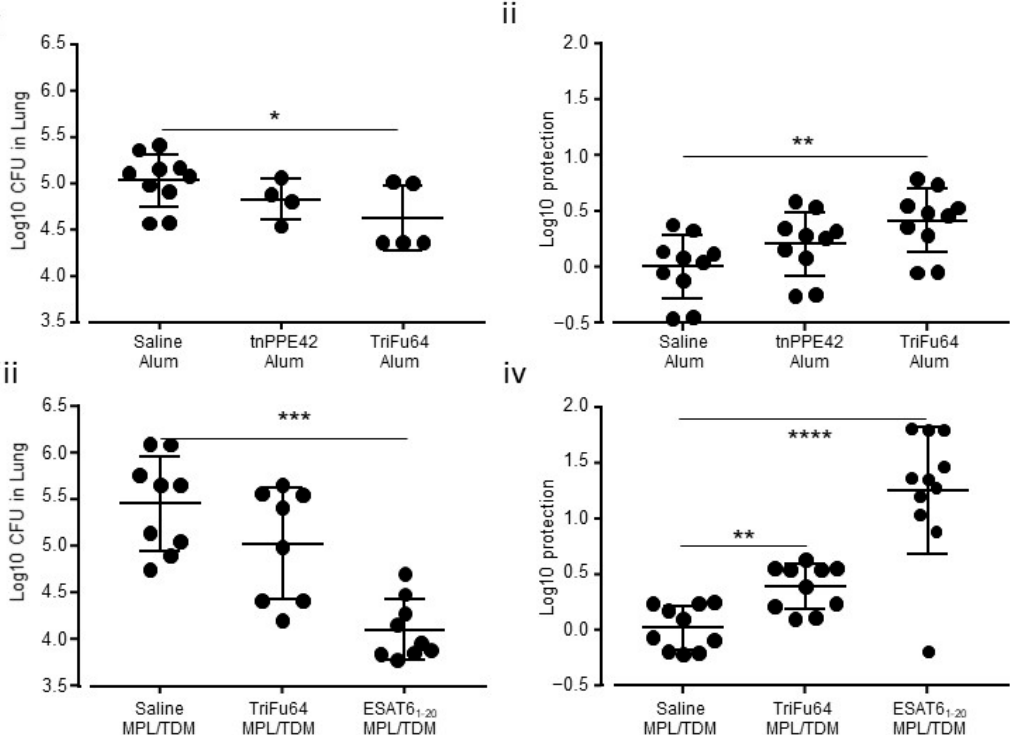
Figure 3. Reduction in bacterial burden in vaccinated mice challenged with Mtb via the aerosol route. Mice were vac- cinated subcutaneously in the rump three times with protein antigens in alum ( i , ii ) or once with protein antigens in MPL/TDM/DDA (MPL/TDM)( iii , iv ). Control mice received the adjuvant with saline ( i – iv ). Vaccinated mice were left to rest and then challenged no earlier than 30 days post vaccination via the aerosol route with approximately 100 colony forming units (CFU) of Mtb. Between 21 and 30 days later the mice were humanely killed, and the lungs homogenized and plated to determine the number of CFU in each lung ( i , iii ). The log10 protection is the difference between each value from the sham group and each of the experimental values for the vaccine formulation ( ii , iv ). Alum vaccine data is from 1 of 1 experiments n = 4–10 ( i , ii ). MPL/TDM/DDA (MPL/TDM) vaccine data ( iii , iv ) is from 2 of 2 experiments n = 6–9.